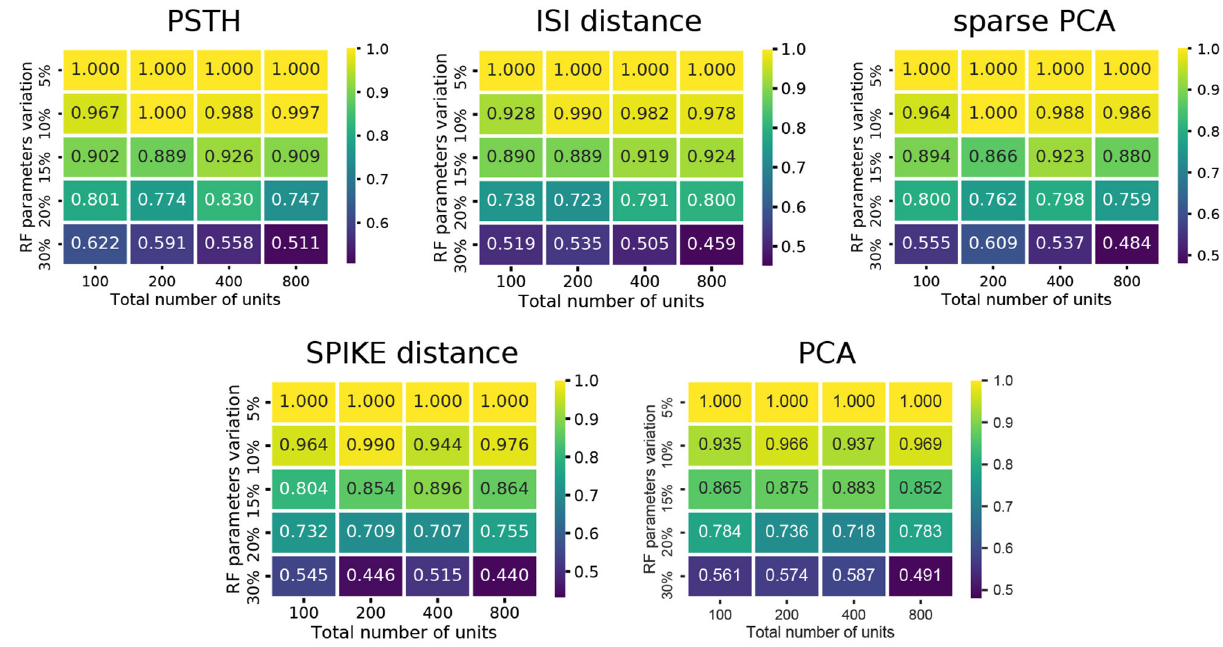
Frontiers in Cellular Neuroscience |